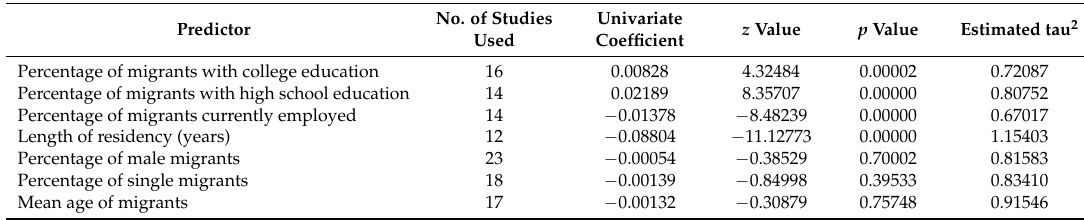
Table 1. Results for meta-regression